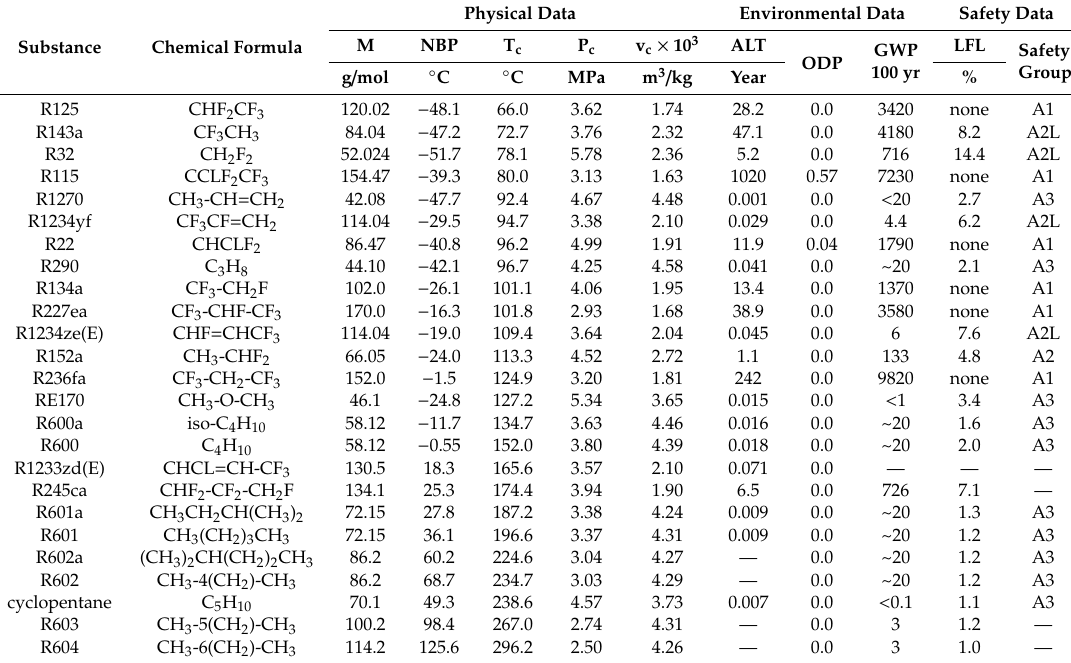
Table 1. Properties of the pure substances